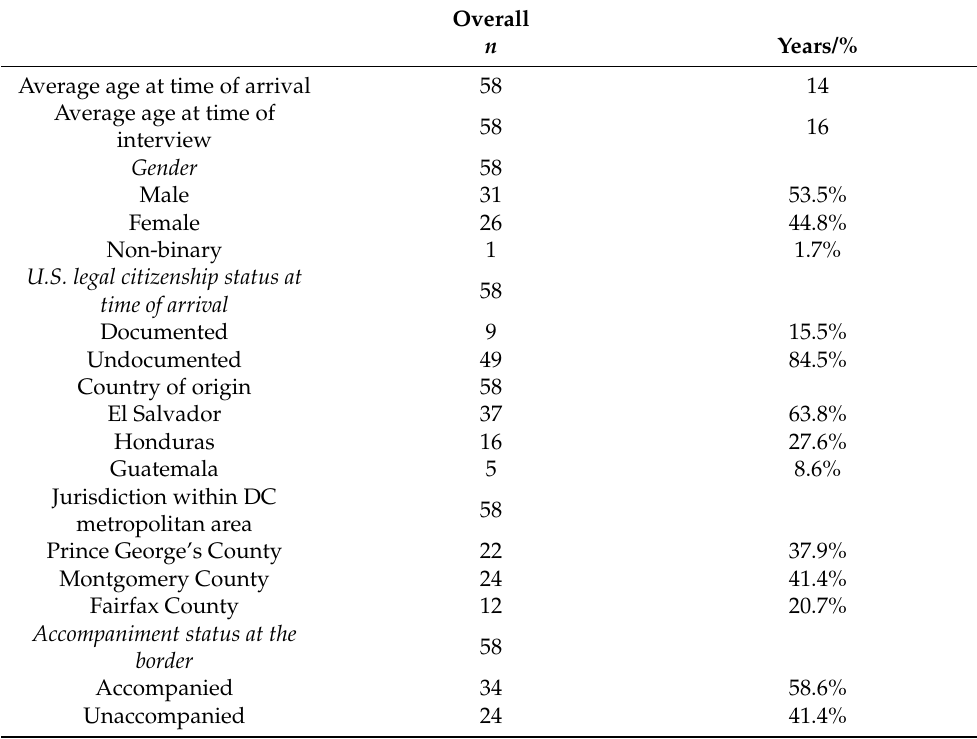
Table 1. Descriptive statistics among immigrant minors in the D.C. metropolitan area ( n = 58).